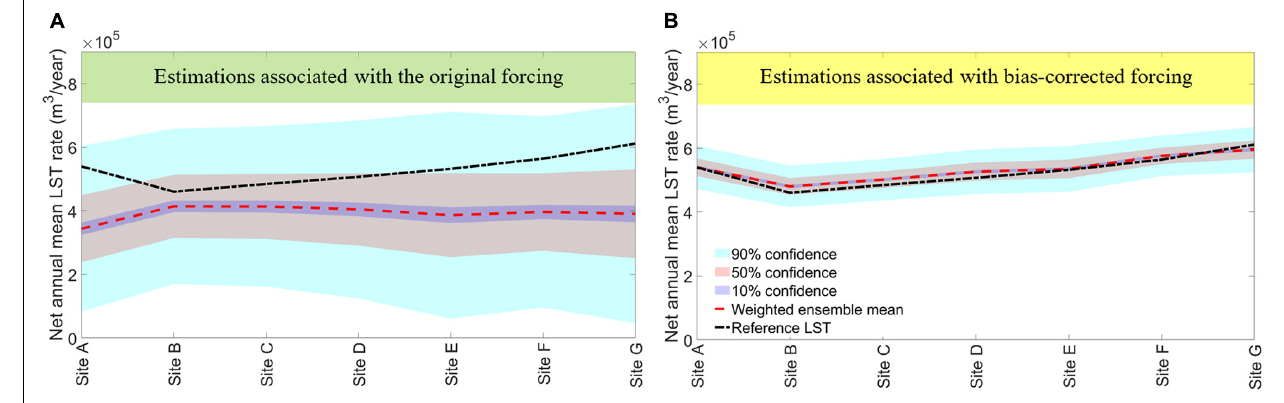
FIGURE 7 | Annual mean LST rates for the baseline period 1979–2005 associated with (A) bias corrected forcing conditions and (B) the original ones; Reference LST was obtained from the average response of the calibrated LST models to the reference forcing; Highlighted areas indicate the uncertainty ranges for LST